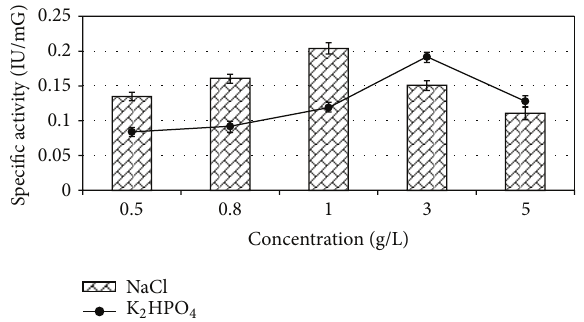
Figure 11: Effect of salt concentrations on specific ADI activity by E. faecium sp. GR7. Results are expressed as the mean ± S.D ( 𝑛 = 3 ), 𝑃 -value < 0.05.